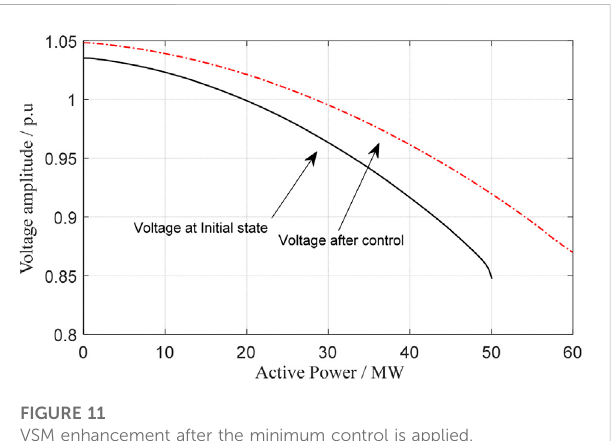
FIGURE 11 VSM enhancement after the minimum control is applied.